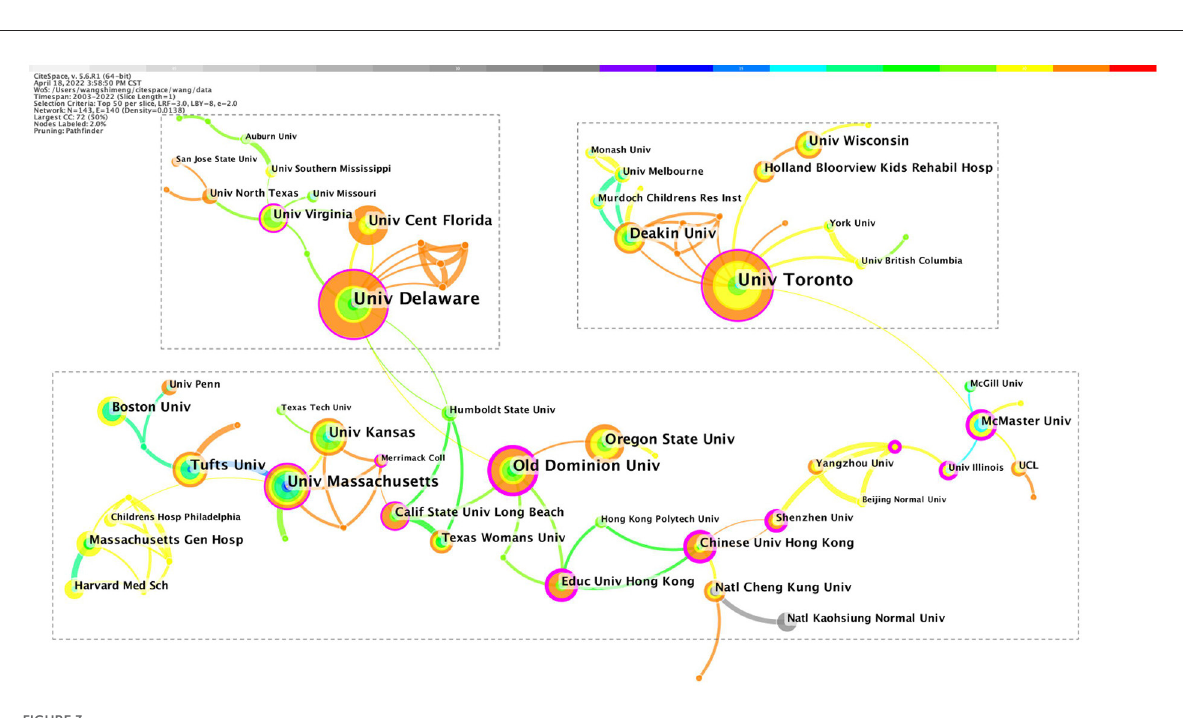
FIGURE3 Co-institutions’ network (2003–2022). The color of the circle represents when the article was published. The larger the node diameter, the more studies institutions have published. The thicker the line between the nodes, the closer the two institutions work